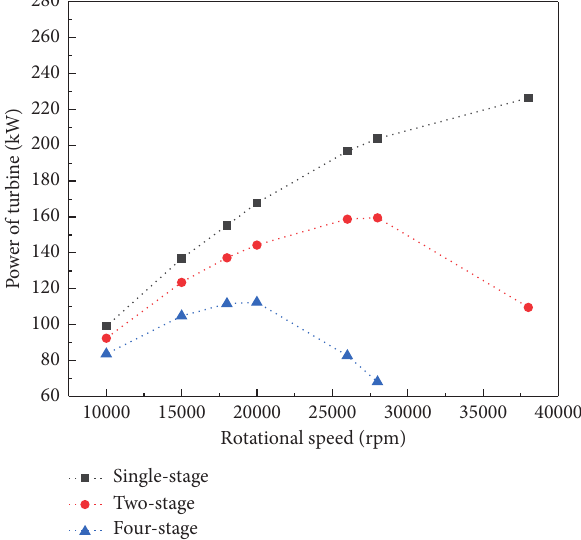
Figure 15: Relationship between output efficiency and rotational speed of small-size